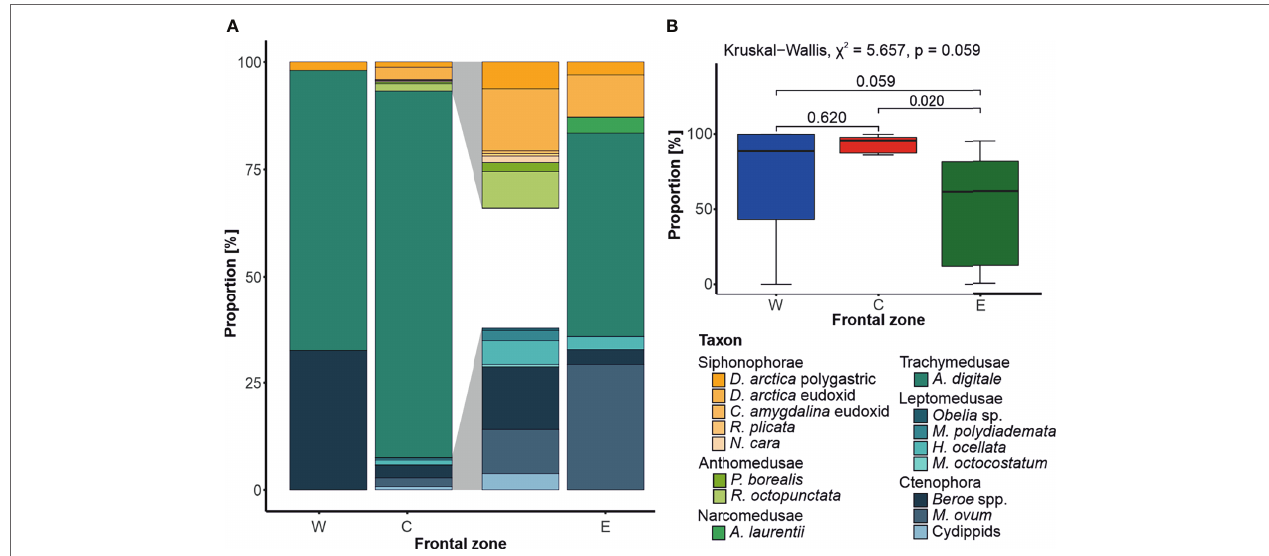
FIGURE 5 | Front-related diversity of gelatinous zooplankton. (A) Species contribution to the gelatinous zooplankton diversity in the investigated frontal zones (W, western; C, central; and E, eastern), calculated based on the square root transformed data, with the 5× magnification of the portions of the middle bar highlighted in gray. (B) Comparison of Aglantha digitale median contribution [%] to the abundance of gelatinous zooplankton community in frontal zones, with the results of statistical tests (Kruskal–Wallis followed by Dunn’s post hoc